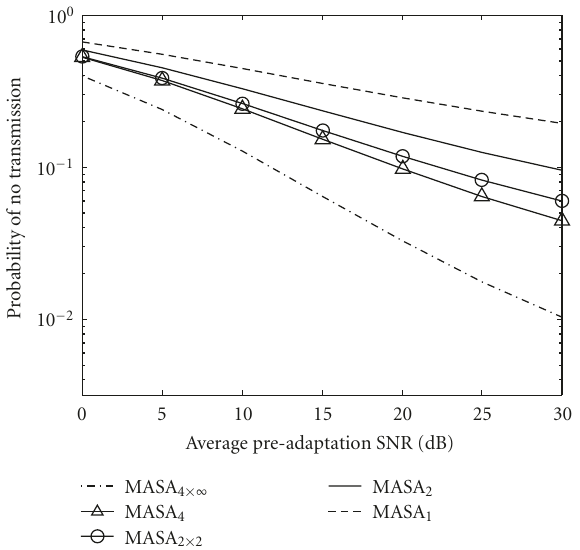
Figure 7: The probability of no transmission P notr. as a function of average preadaptation SNR [15] ( c (cid:2) 2006 IEEE).